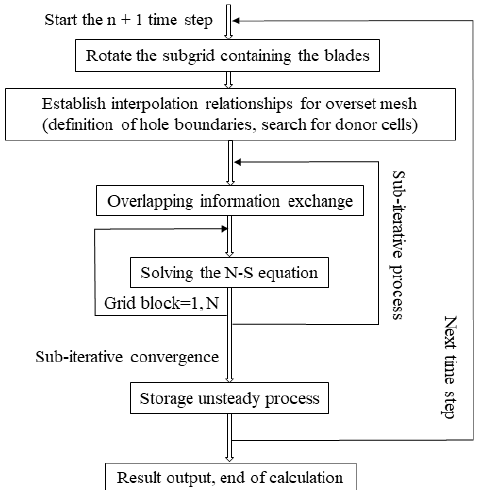
Figure 4. Flow diagram of the dual time stepping method for overset grid.